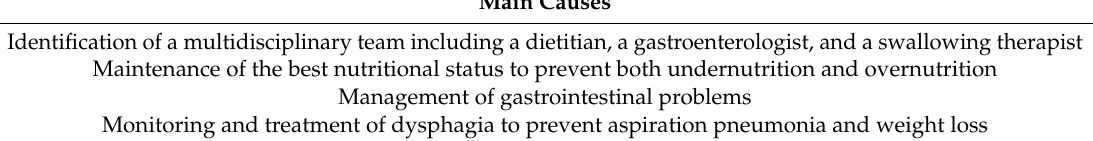
Table 5. Main recommendations for the management of nutritional complications in patients with Duchenne muscular dystrophy